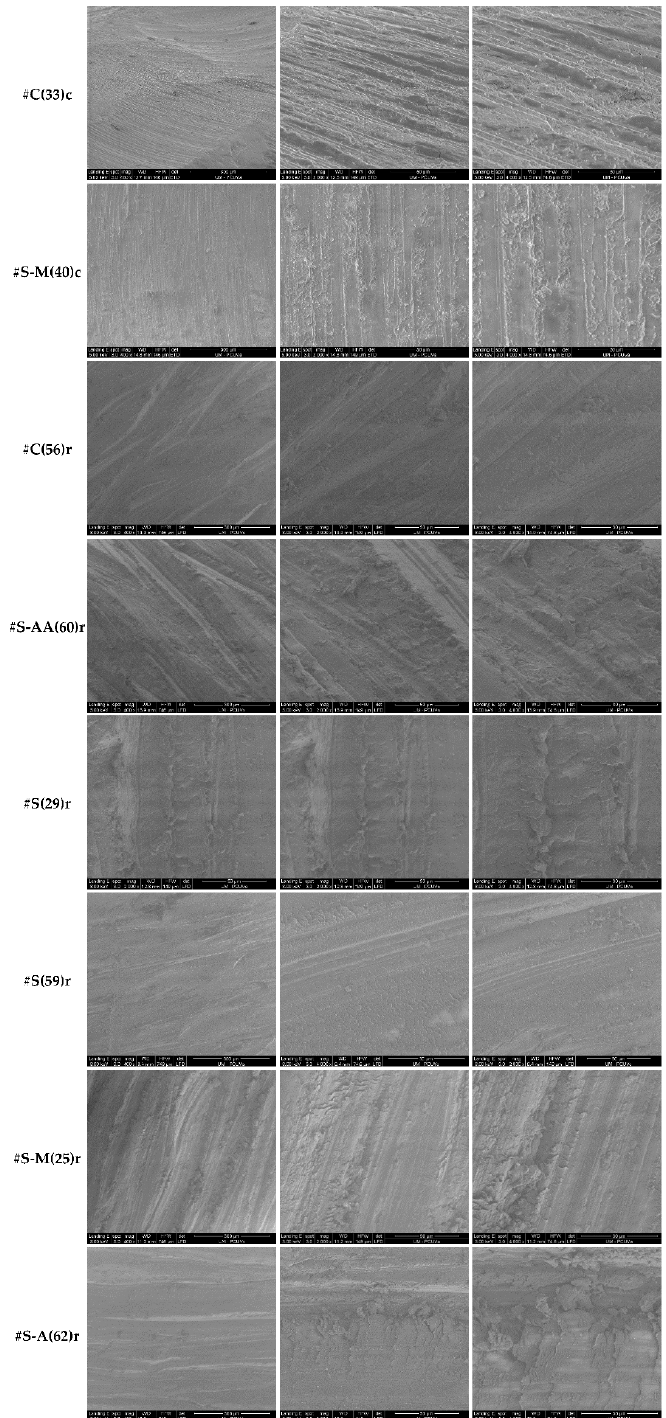
Figure 6. Scanning electron micrographs of a representative crown enamel (“c”) and root cementum (“r”) samples at increasing magnifications (from left to right). The conditions of patients ʹ teeth are indicated as follows: alcohol (A); smoker (S); treatment with psychotherapeutic drugs (M); anti ‐ inflammatory drugs (AA); control (C). The age of the patient is shown in parentheses.